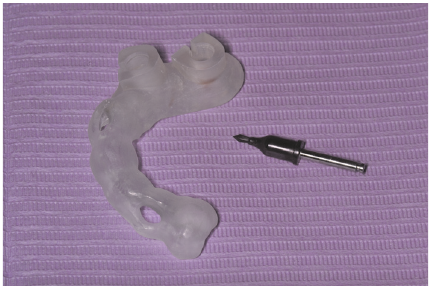
Figure 2: The stereolithographic surgical guide utilized in all cases had the guide sleeve incorporated in the design, eliminating the need for additional insertion of metal guide sleeves. All surgical drills used had 3 parts: the stopper part, the guide part, and the drilling part [19]. Stopper and guide parts are identical for all drills and especially designed for R2Gate (cid:2) surgical template. Drilling part varies in length and diameter according to the drilling